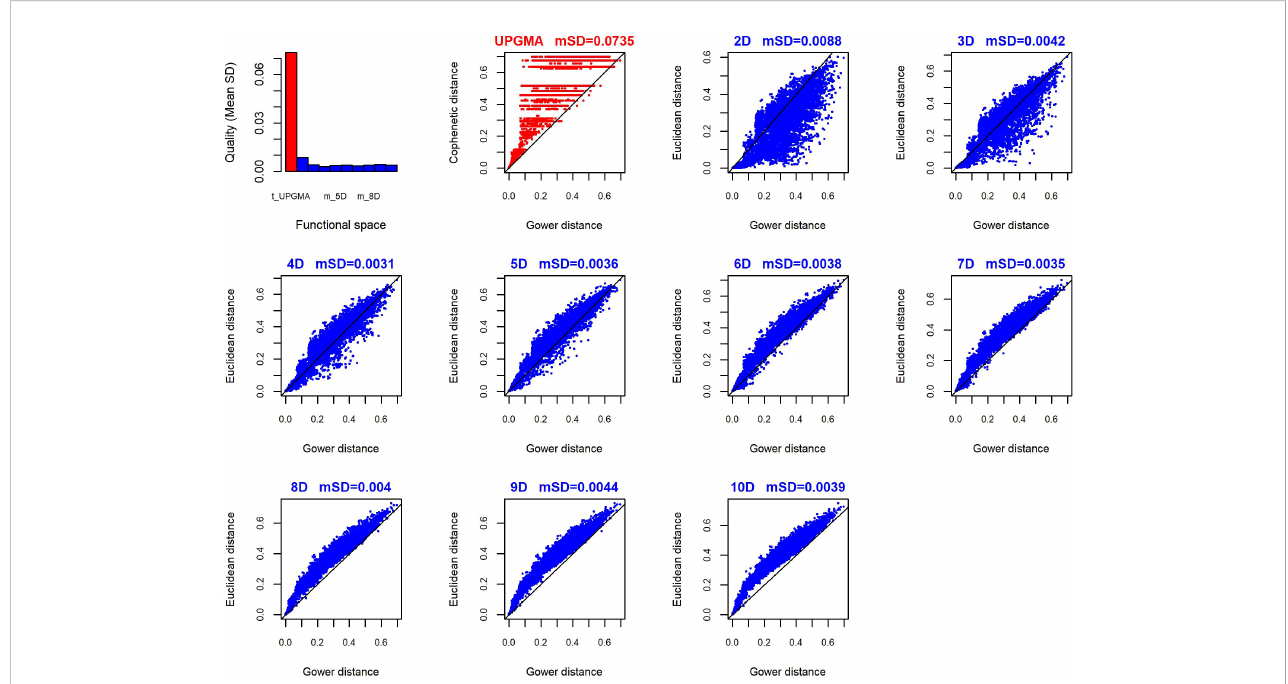
FIGURE 2 The quality of functional spaces used to compute functional diversity metrics for the PNSAV fi sh assemblages sampled between 2006 and 2021. The top-left panel shows the mean squared deviation for two to ten functional spaces and dendrogram. The remaining ten panels show the correlation between the initial Gower ’ s distances and the standardized distances in each of the ten functional spaces and dendrogram. The mean Squared-Deviation (mSD) equals the average deviation between Gower ’ s distance and Euclidean distance for multidimensional spaces and Cophenetic distance for dendrogram, mSD can be viewed like an average error or quality space metric. Each point represents a